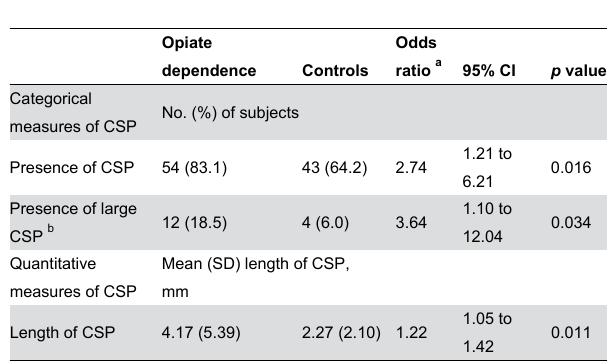
Table 2. The odds ratios for opiate dependence according to the presence of cavum